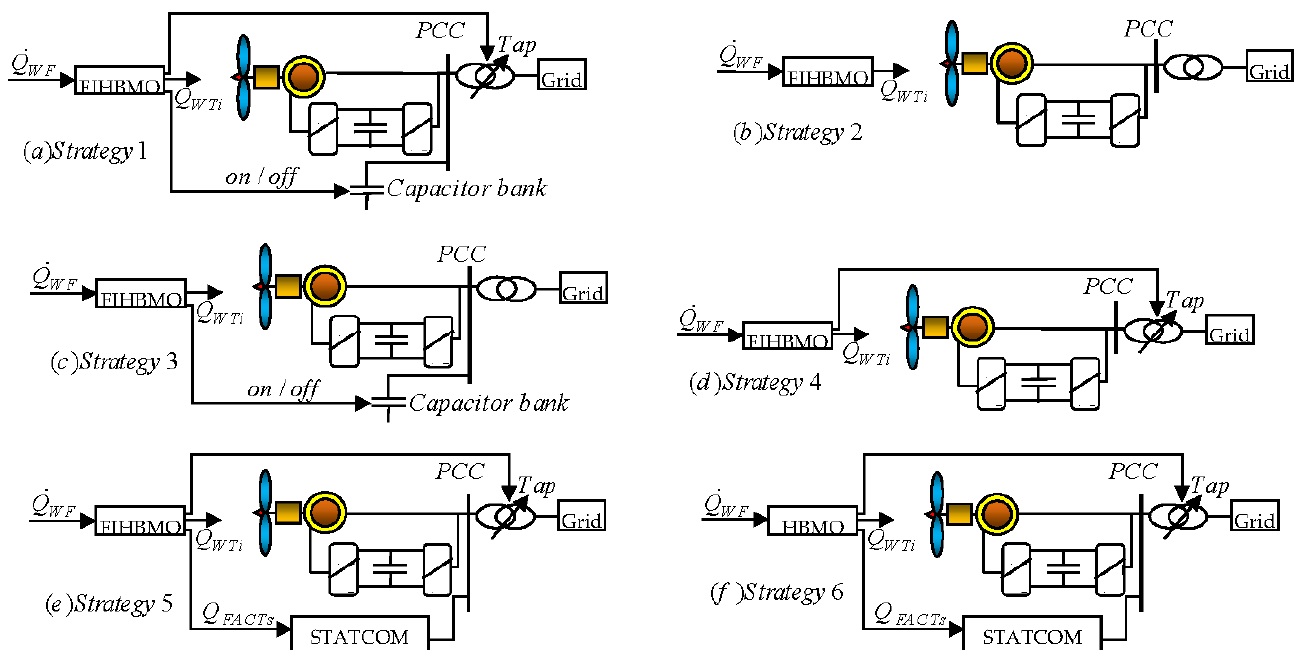
Figure 8. Structure of the tested wind farm.